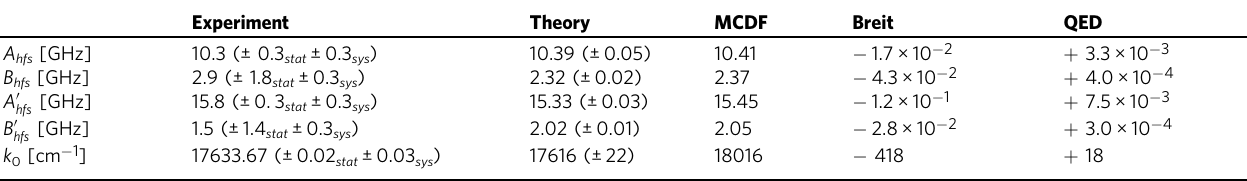
5 s ) J = 3 and (4 d 9 5 s ) J = 2 in 127 I 7 + 5 = 2 3 = 2